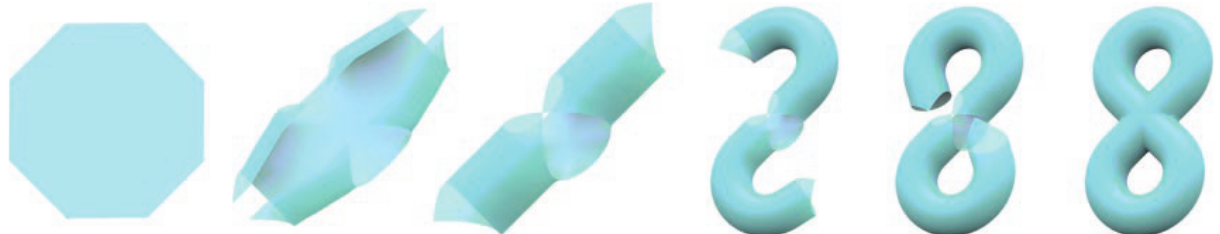
Figure 21. An octagon can be glued to form a genus two surface. Figure courtesy Myfanwy Evans.